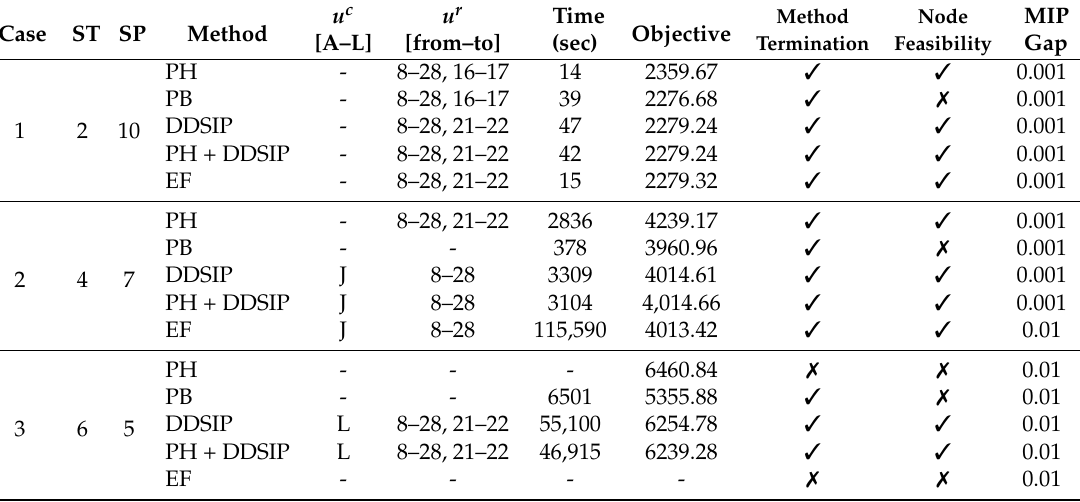
Table 4. Overall expansion results for different time horizons and number of